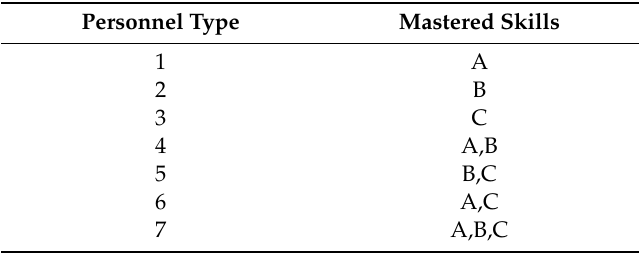
Table 1. Skill types and their